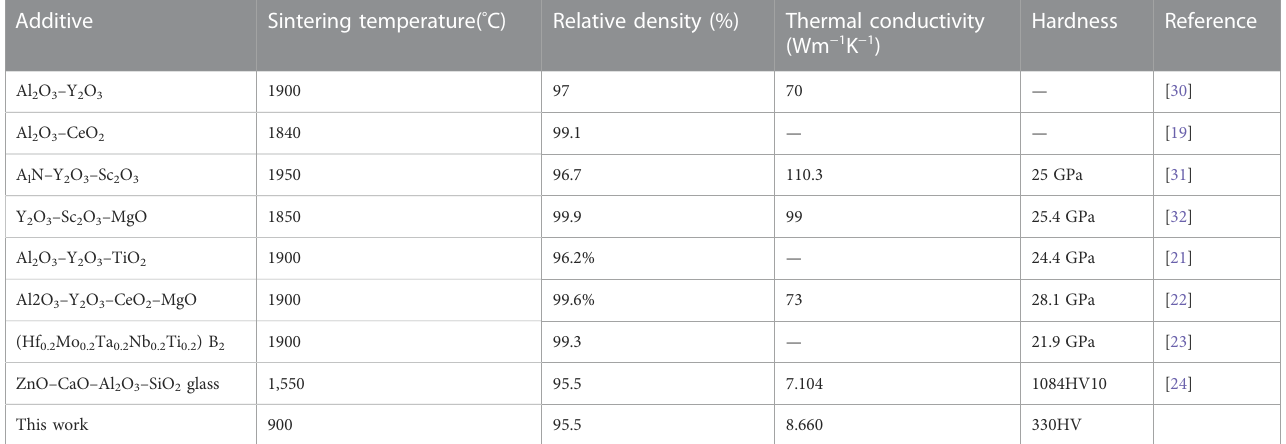
TABLE 1 Additives, sintering temperature, relative density, thermal conductivity, and hardness of the SiC composites reported in the literatures.